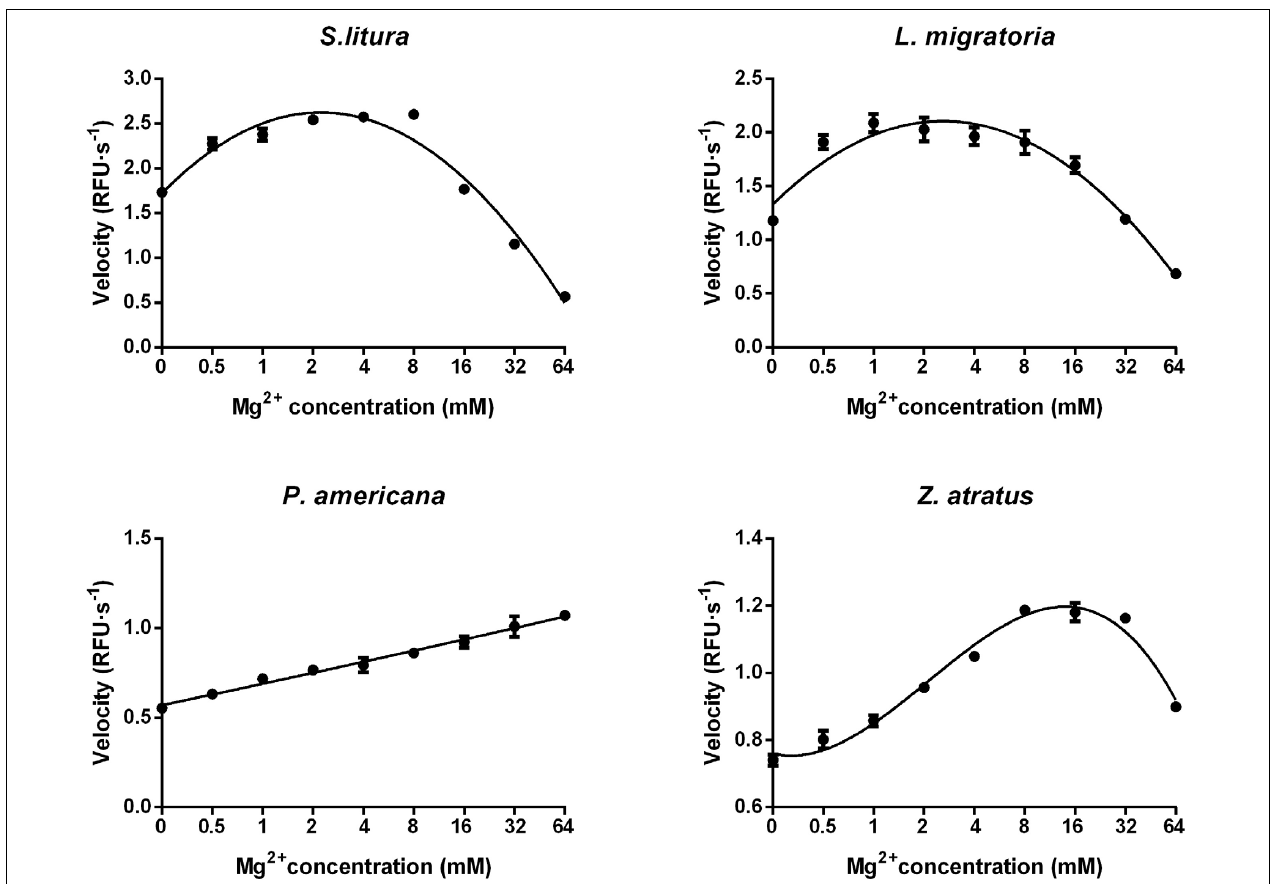
FIGURE 6 | Distinct impacts of Mg 2 + concentrations on the dsRNA degrading nucleases of four insects. The homogenates were prepared from whole body of different insects. Tested conditions were conducted under their optimal pH (pH 10.0 for S. litura and pH 9.0 for the other three species). Each reaction containing 19 µ L enzyme solution and 1 µ L fluorescence labeled dsRNA substrate at a final concentration of 0.5 µ M. The fluorescence intensity in different reactions were continuously monitored at 37 ◦ C. Values are mean ± SE; n =